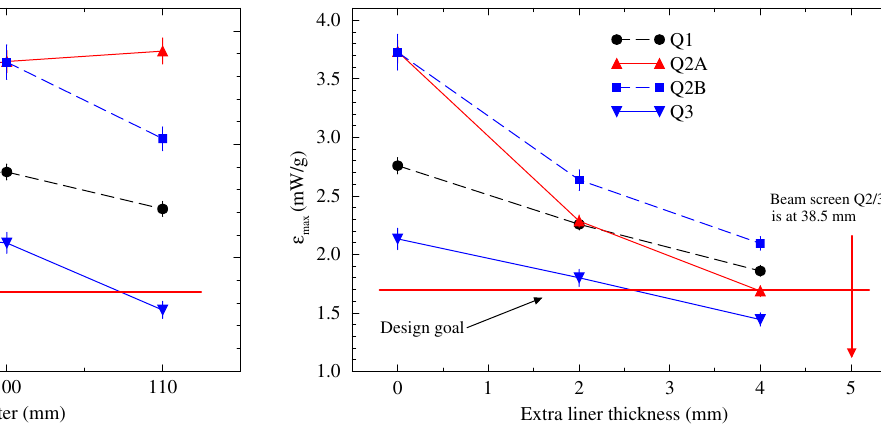
FIG. 5. (Color) Distributions of maximum peak power density in the Nb Sn quadrupoles vs inner coil diameter calculated for a 3 baseline stainless steel liner. The term ‘‘maximum’’ refers here to the highest peak power density observed over a magnet length.